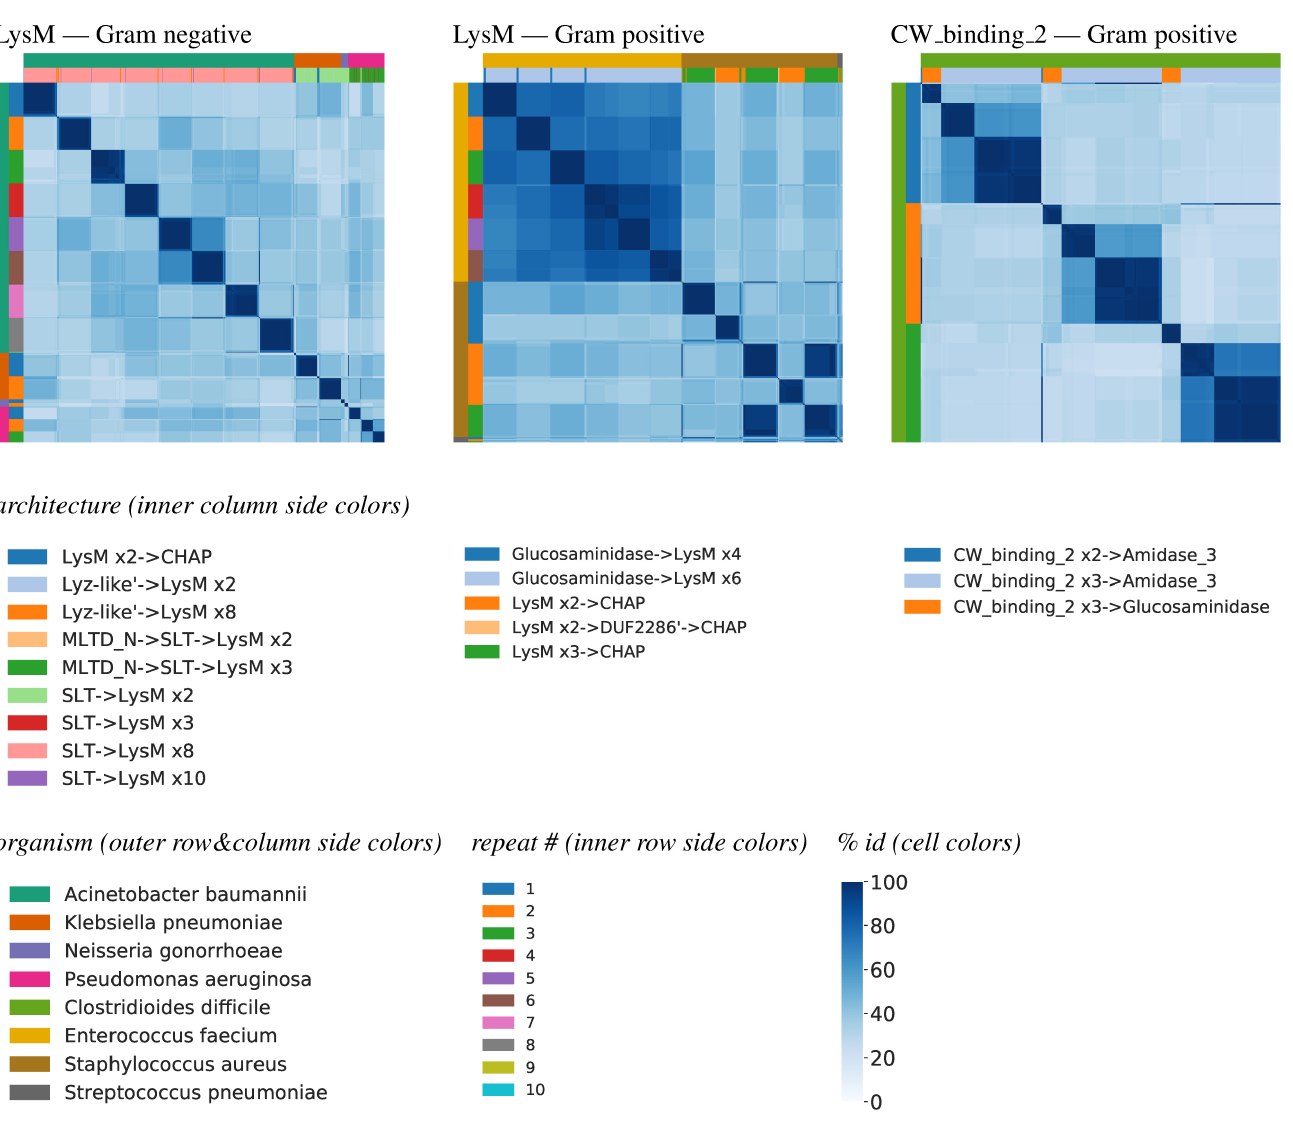
Fig 7. Domain sequence diversity by repeat position. Heatmaps as in Fig 5, except with the colors above the columns indicating the organism and architecture, and the colors beside the rows indicating the organism and repeat number. Thus cells are grouped by organism and repeat number, and clustered within those based on sequence identity